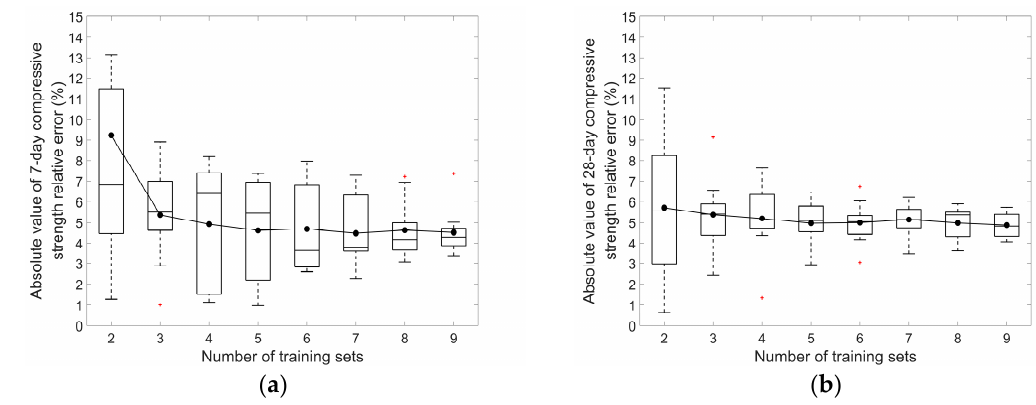
Figure 8. Sensitivity analysis between the number of training sets, and the absolute value of the relative error between predicted and tested ( a ) 7-day and ( b ) 28-day compressive strength of group 6. 4.2. Comparison to BP Neural Network Table 4 shows the tested compressive strength results from XU, G.Q. [37], predicted compressive strength by BP neural network model and predicted compressive strength by the CCSDOT model. The BP neural network model used 61 groups of data and the CCSDOT model only used 10 groups of data. Table 4. Compressive strength of green concrete containing fly ash and limestone flour. BP: back propagation. Group